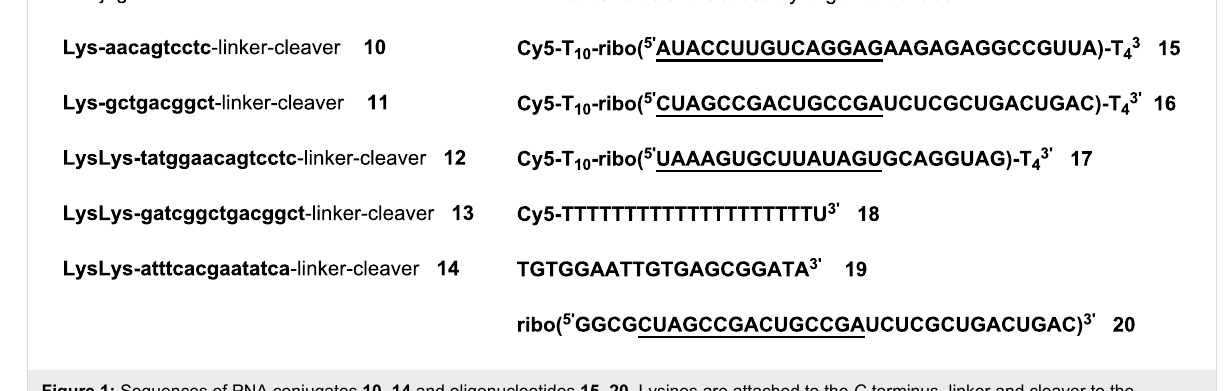
Figure 1: Sequences of PNA conjugates 10–14 and oligonucleotides 15–20 . Lysines are attached to the C -terminus, linker and cleaver to the N -terminus. The parts with base complementarity to 15mer PNAs, i.e., the binding sites, are underlined. When 10mer PNAs bind to substrates 15 and 16 , the first five ribonucleotides at the 5’ end will remain single